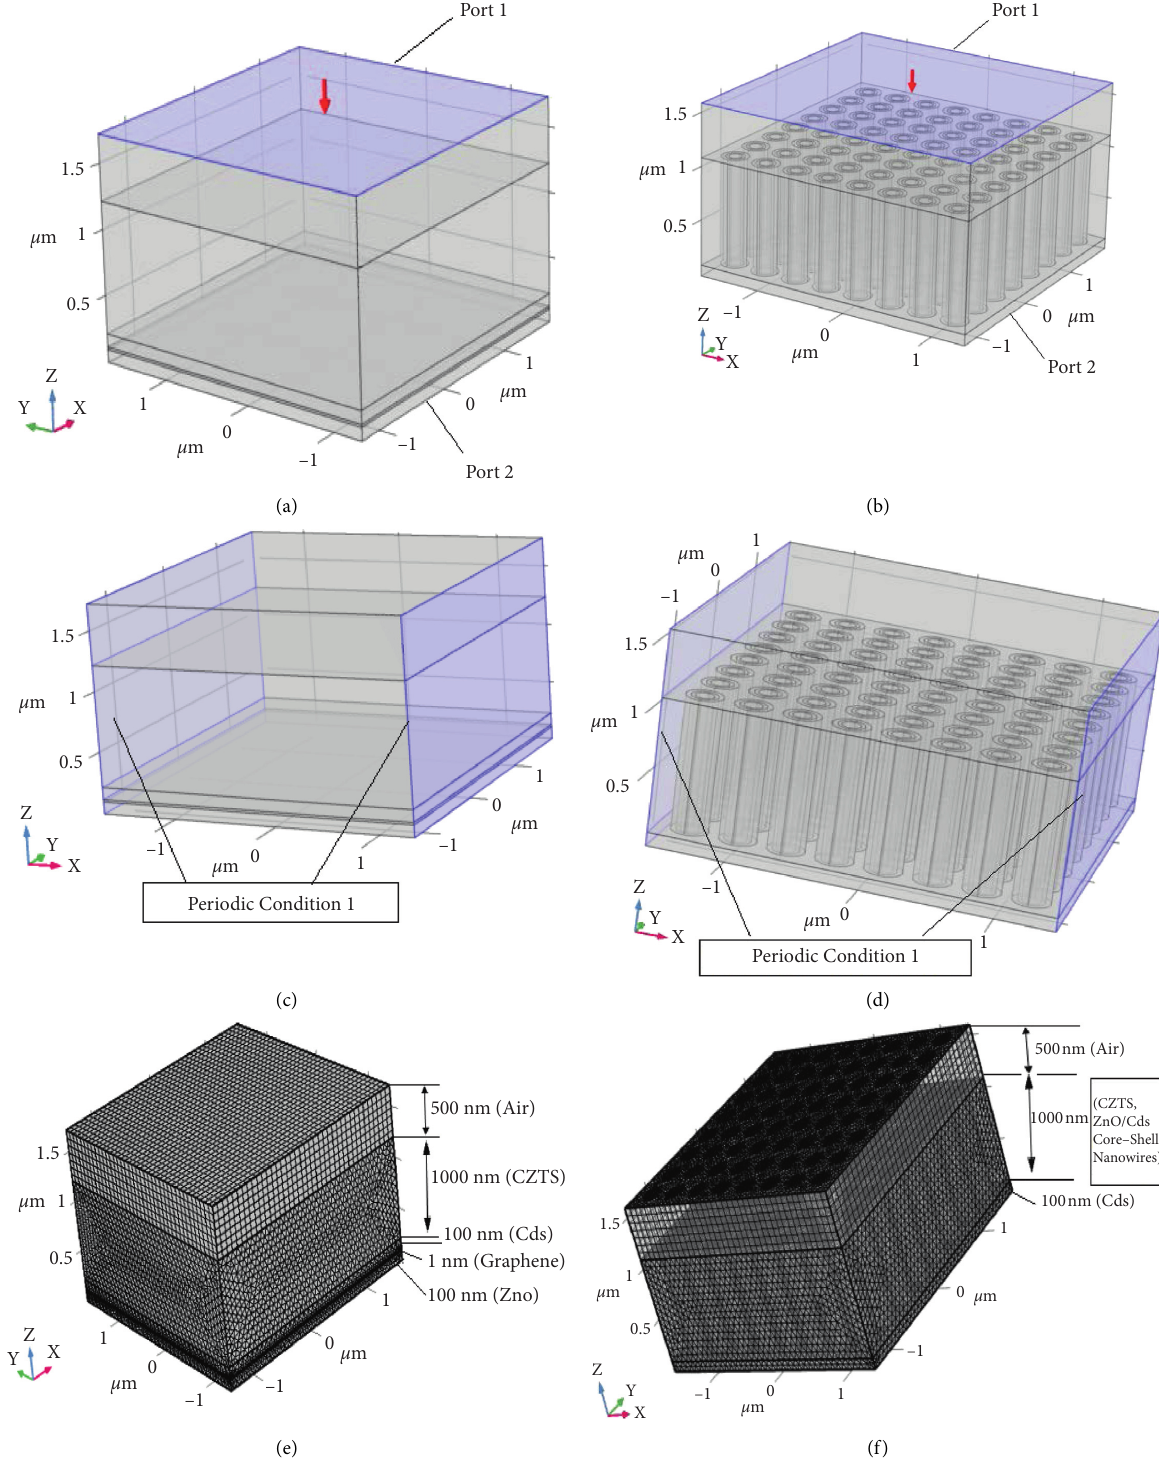
Figure 3: Schematic structure of simulation models: (a, b) schematic diagrams of the location of the port, respectively, of thin-film and ZnO/ CdS core-shell nanowire models; (c, d) schematic diagram, respectively, of the periodic conditions of thin-film and ZnO/CdS core-shell nanowire models; and (e, f) schematic diagram, respectively, of meshing of thin-film and ZnO/CdS core-shell nanowire